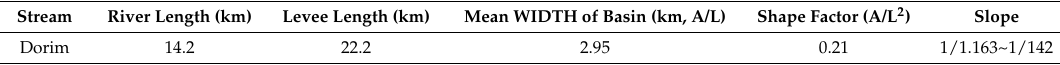
Table 3. The characteristics of the Dorim stream.